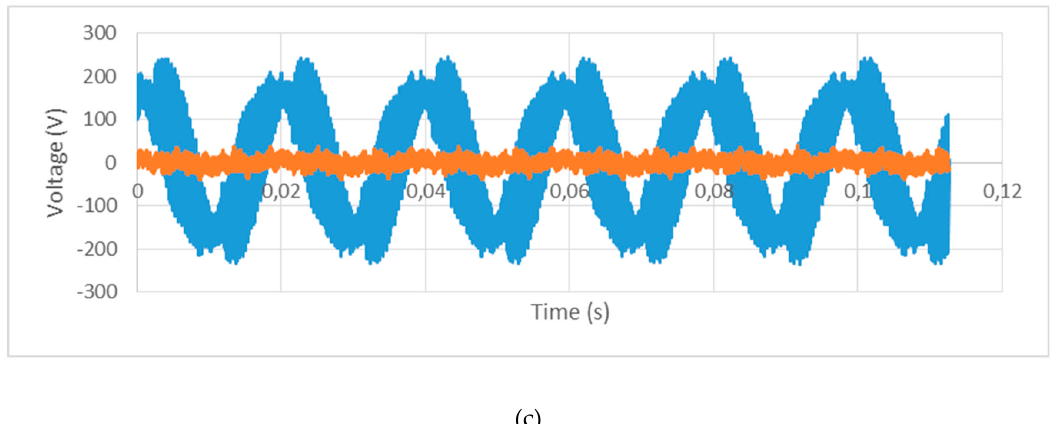
Figure 12. Waveform of the output phase voltage (blue) and CMV (orange), for the shift angle ψ = 60° ( a ); ψ = ‐ 60° ( b ) and ψ = 180° ( c ).